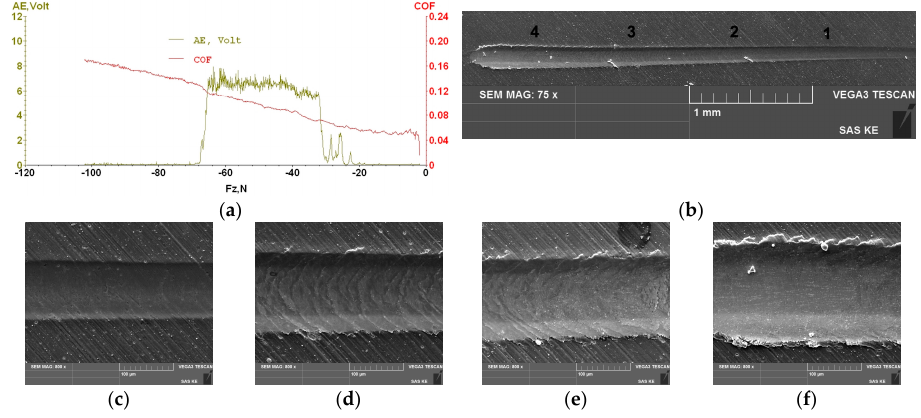
Figure 10. Acoustic emission of CrN coating: ( a ) record AE-Fz, COF-Fz; ( b ) scratch–disposition and ( c – f ) detail of coating failure, position 1–4 respectively.